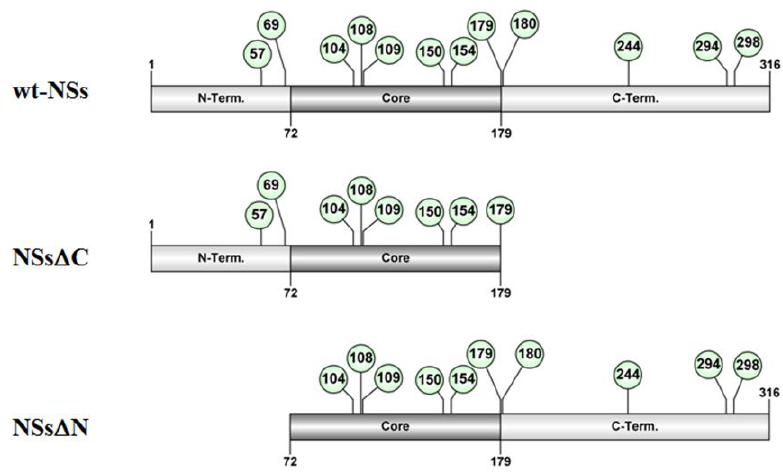
Figure 1. Schematic representation of the of TOSV NSs full-length (wt-NSs) sequence, N-(NSs ∆ N), or C-terminus deleted (NSs ∆ C) variants. Green dots indicate the lysine residues with a high predictive score for ubiquitination.